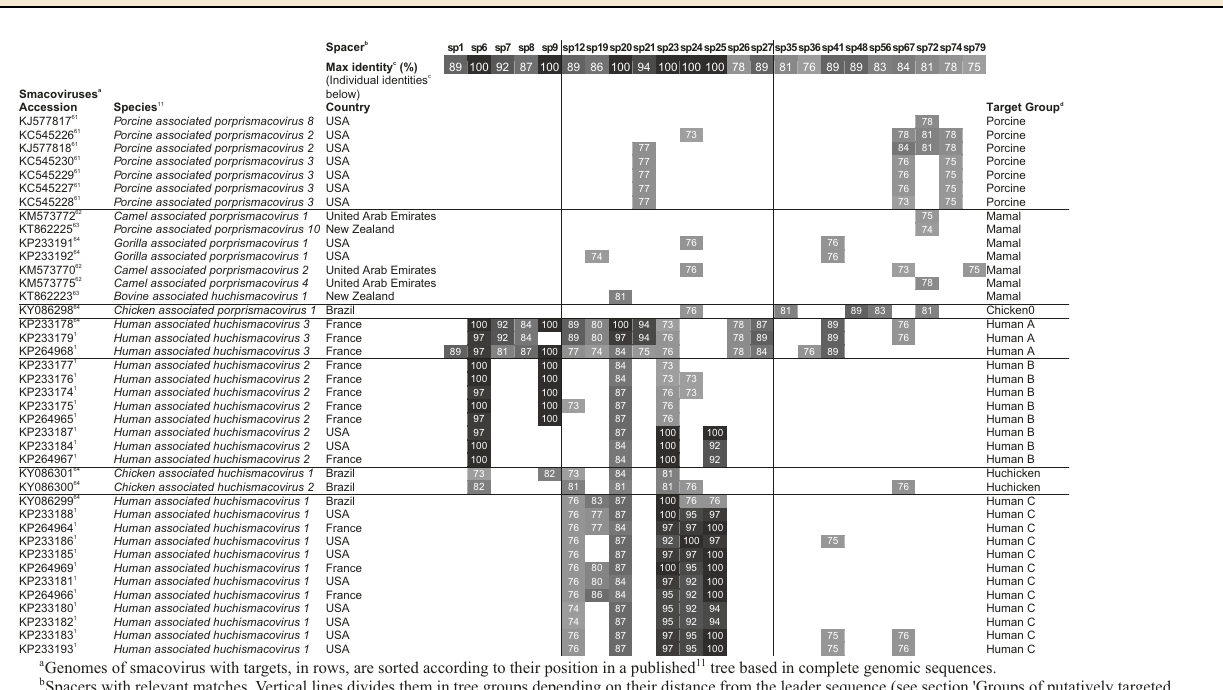
Table 1 Targets of Ca . M. intestinalis CRISPR in smacoviral genomes